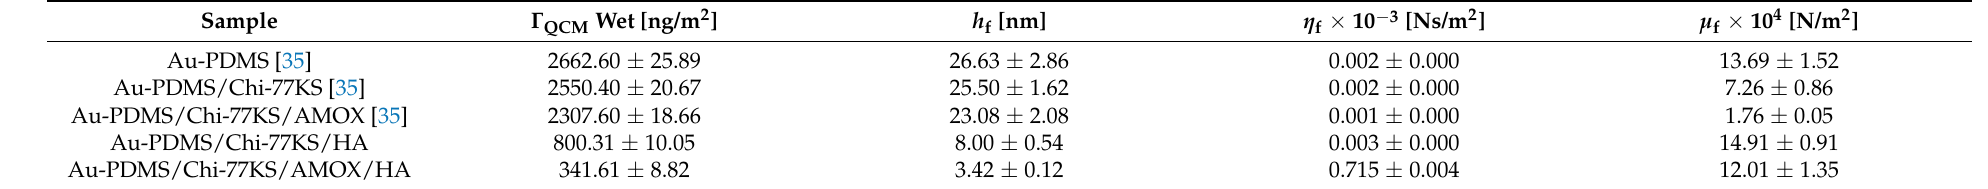
Table 4. Viscoelastic properties—the adsorbed mass ( Γ QCM ), film thickness ( h f ), viscosity ( η f ), and elastic shear modulus ( µ f ) of adsorbed mixed protein (Mix) layer onto various samples, including first (Chi-77KS, Chi-77KS/AMOX) and the second layer